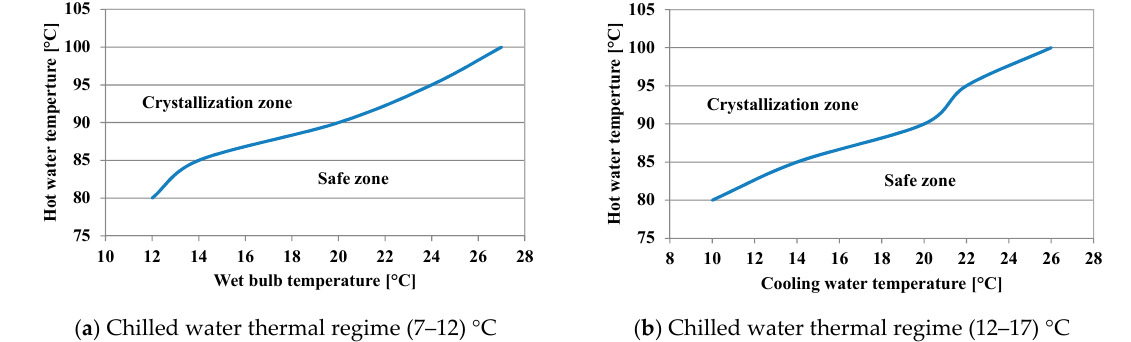
Figure 9. Safe zone and crystallization zone.